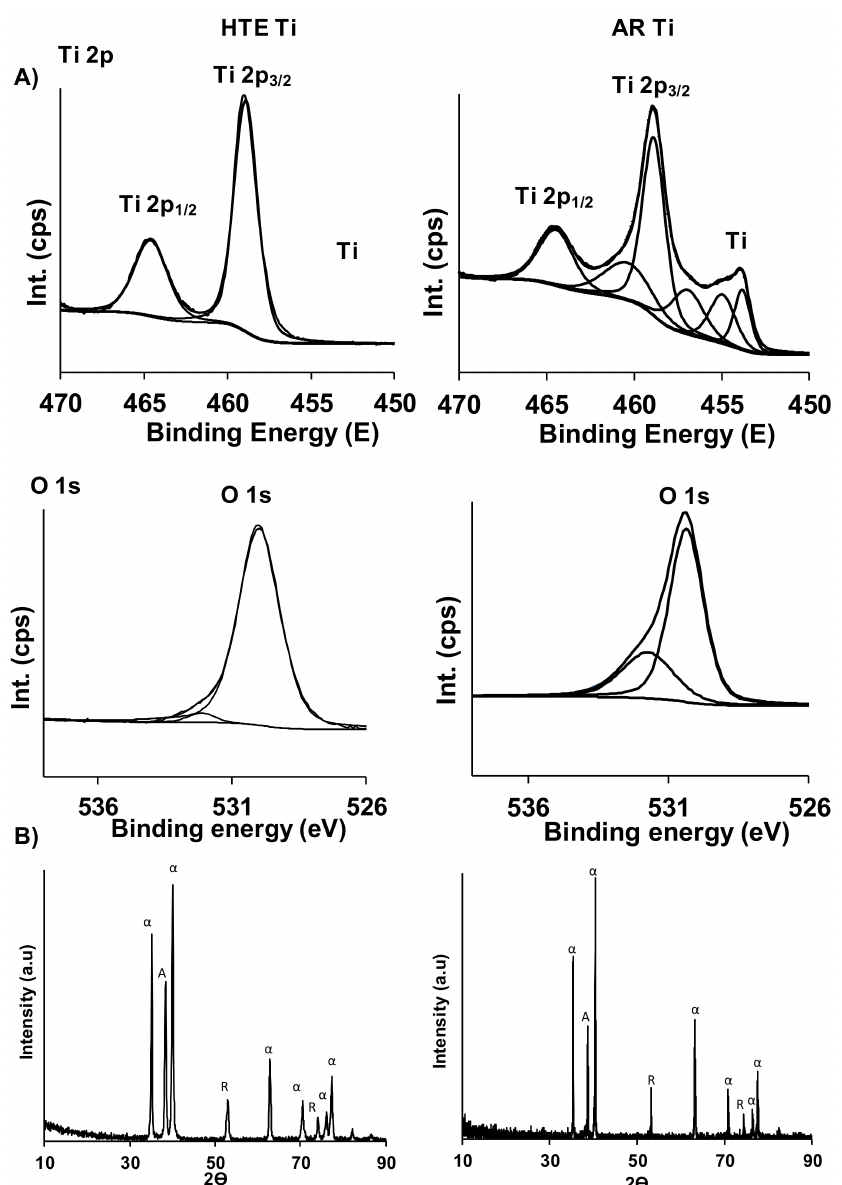
Figure 2. Surface chemistry and crystallinity characteristics of titanium surfaces. ( A ) XPS spectra of Ti 2p, and O 1s for the as-received (right) and HTE (left) titanium substrata. ( B ) X-ray diffractograms demonstrating the crystalline phases present on as-received (right) and HTE (left)